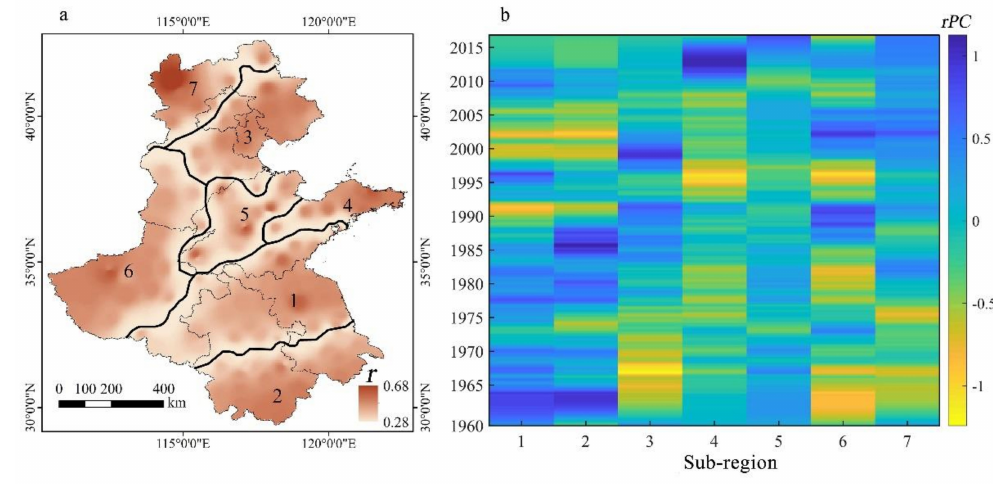
Figure 5. Sub-regions recognized in the North China Plain for winter drought variability ( a ) and the standardized rotated principal component (rPC) time series for sub-regions in winter ( b ). Each sub-region in ( a ) has a number that corresponds to its rPC time series in ( b ),